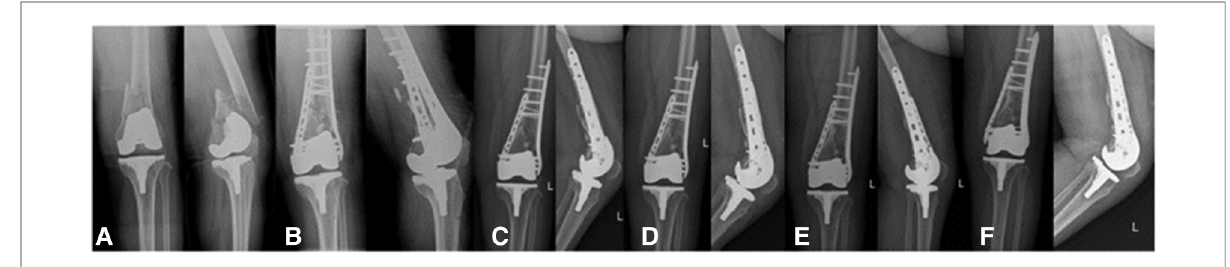
FIGURE 2 Anteroposterior and lateral radiographs of the left knee: preoperative x-ray image ( A ), postoperative x-ray images ( B ), radiograph 7 months after surgery ( C ), radiograph 9 months after surgery ( D ), radiograph 21 months after surgery ( E ), radiograph 34 months after surgery ( F ).